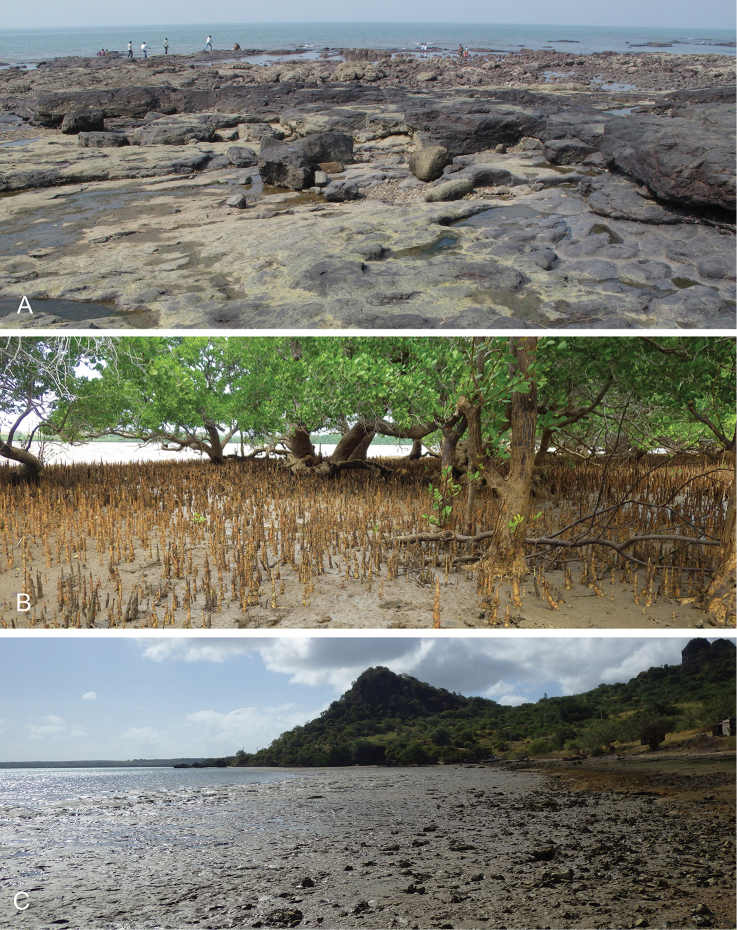
Habitats, Peronia
verruculataA unit #4 B, C unit #5 A India, Mumbai, solid rock area, some crevices (st 44) B Madagascar, sandy mangrove of Bruguiera, on sandy mud in between rocks (st 162) C Madagascar, rocky platform near Avicennia and Rhizophora mangrove (st 158).